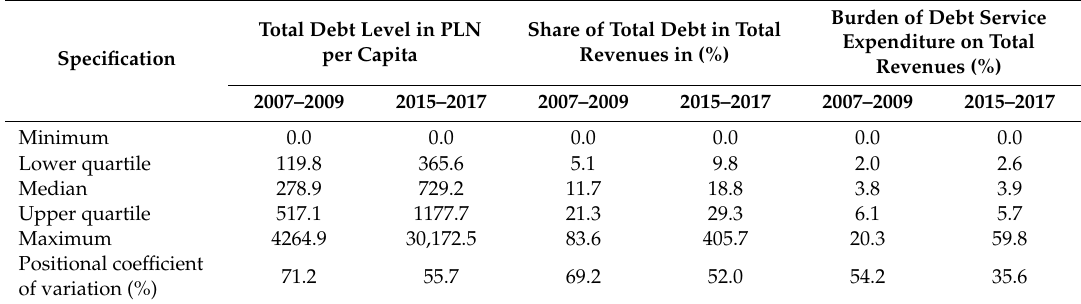
Table 2. Descriptive statistics of the value of the selected debt indicators of rural communes in Poland